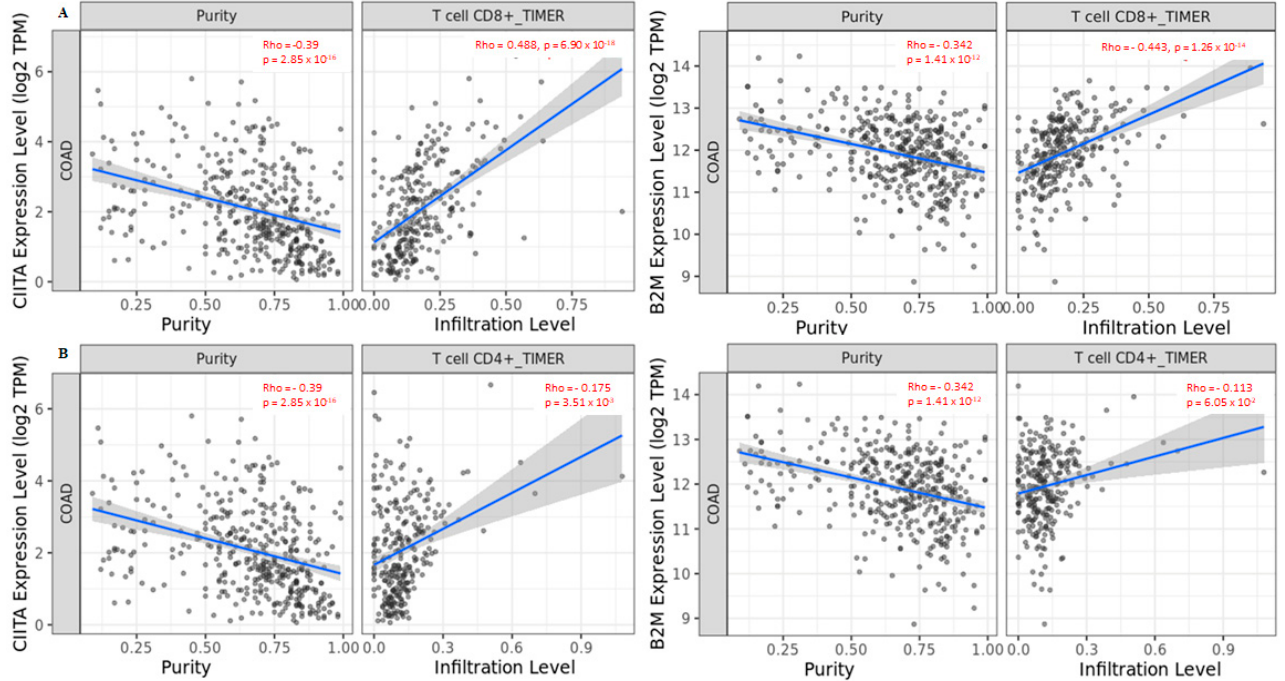
Figure 5. Correlation between CIITA and B2M in ( A ) CD8 + T cells and ( B ) CD4 + T cells in COAD